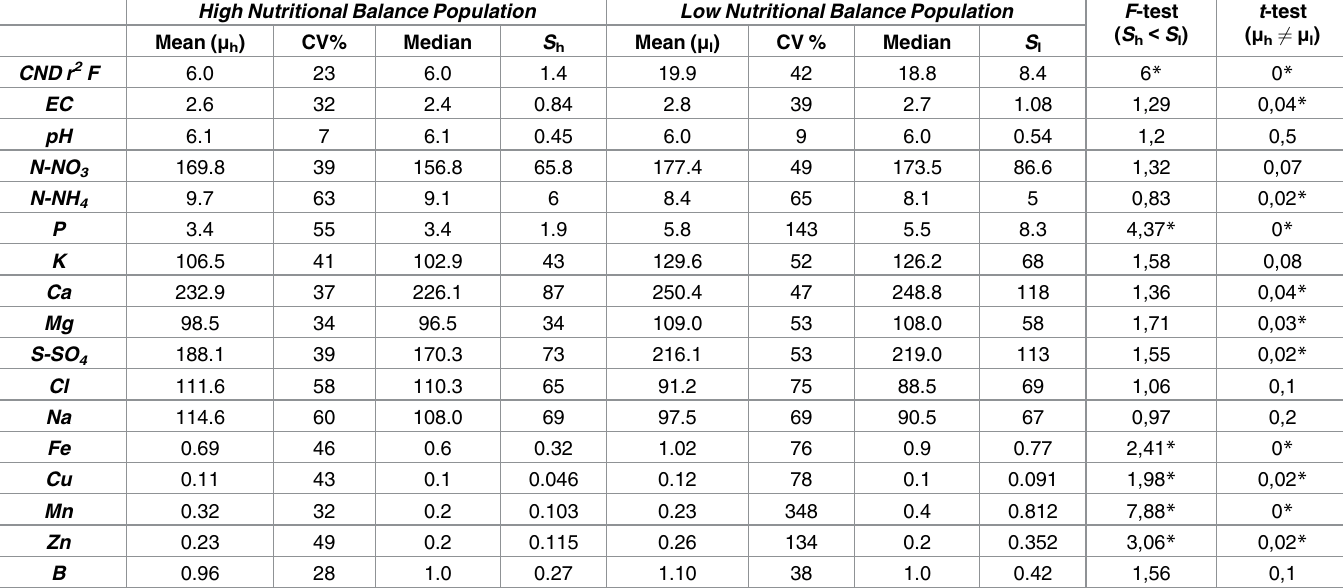
Table 2. Basic statistics in populations with high and low nutritional balance, and results of the F -test and t- test applied to the calculation of CND norms of saturated soil extract analysis from rose crops. (Foliar CND r 2 < 7.4 on high nutritionalbalancepopulation). High Nutritional Balance